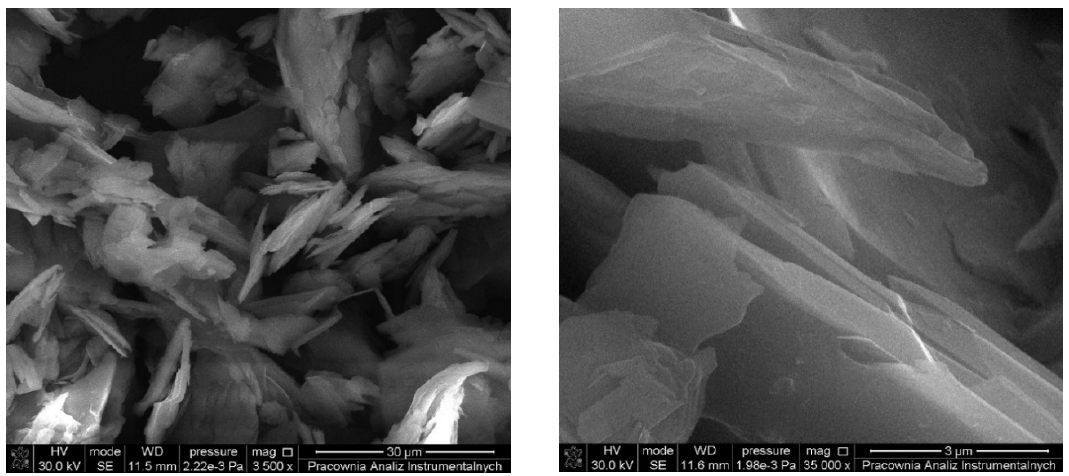
Figure 2. SEM images of the talc.